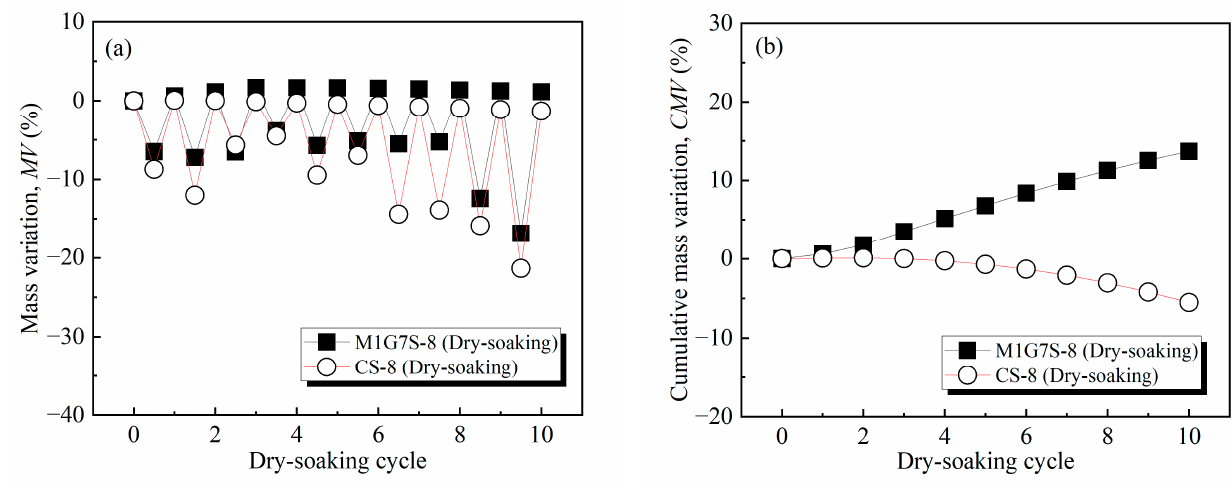
Figure 8. Variations of ( a ) MV and ( b ) CMV with dry–soaking cycle for shield residues stabilized by M1G7-8 and CS-8 with dry–soaking cycle.